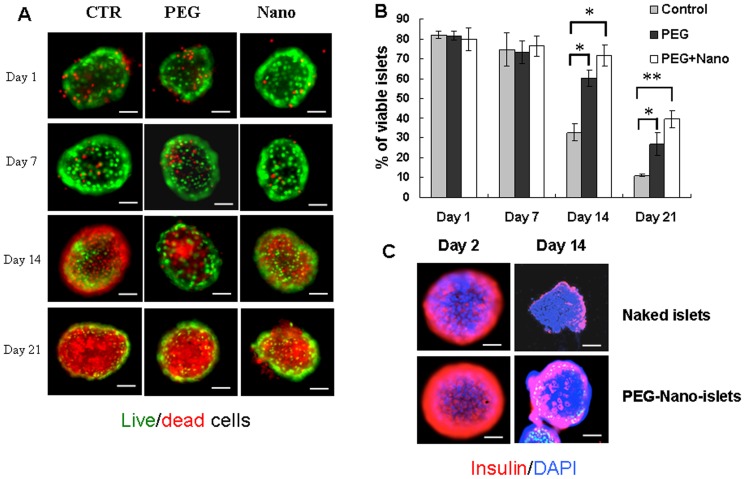
Prolonged viability of encapsulated islets in vitro.(A) Staining of viable (green) versus dead (red) cells in cultures of naked islets (CTR), pegylated islets (PEG), or pegylated plus empty-nanoparticle islets (Nano) at 1 d, 7 d, 14 d, and 21 d. (B) Percentages of viable cells in the different groups during culture. (C) Insulin staining in naked (CTR) and PEG-Nano-coated islets at 2 d and 14 d culture: more insulin positive cells were observed in islets encapsulated with nanoparticles (lower panels) compared to naked islets (upper panels). At least 10 islets were included in each group. Red represents insulin staining, blue staining (DAPI) represents nuclear staining in all cells. * p<0.05 and ** p<0.01.